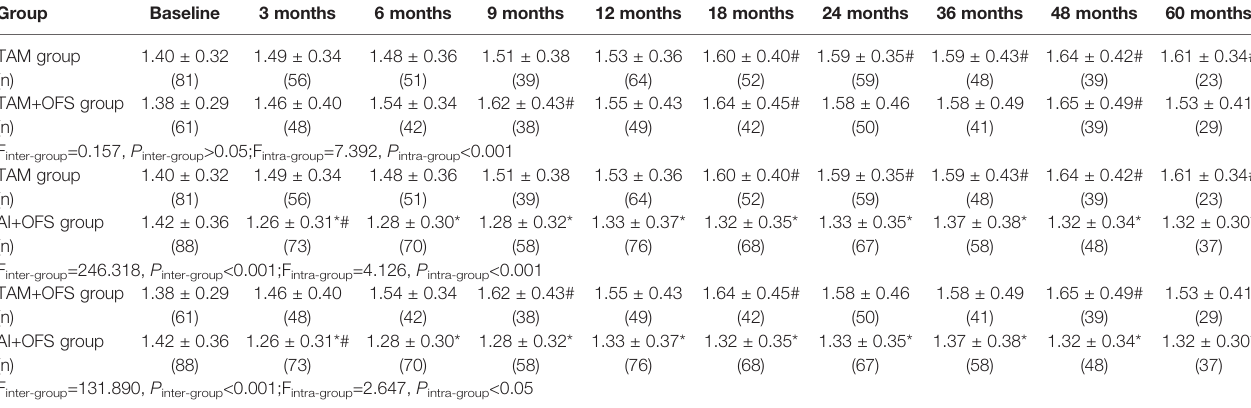
TABLE 6 | Comparison of high-density lipoprotein cholesterol (HDL-C) level at different time-points over the course of treatment.